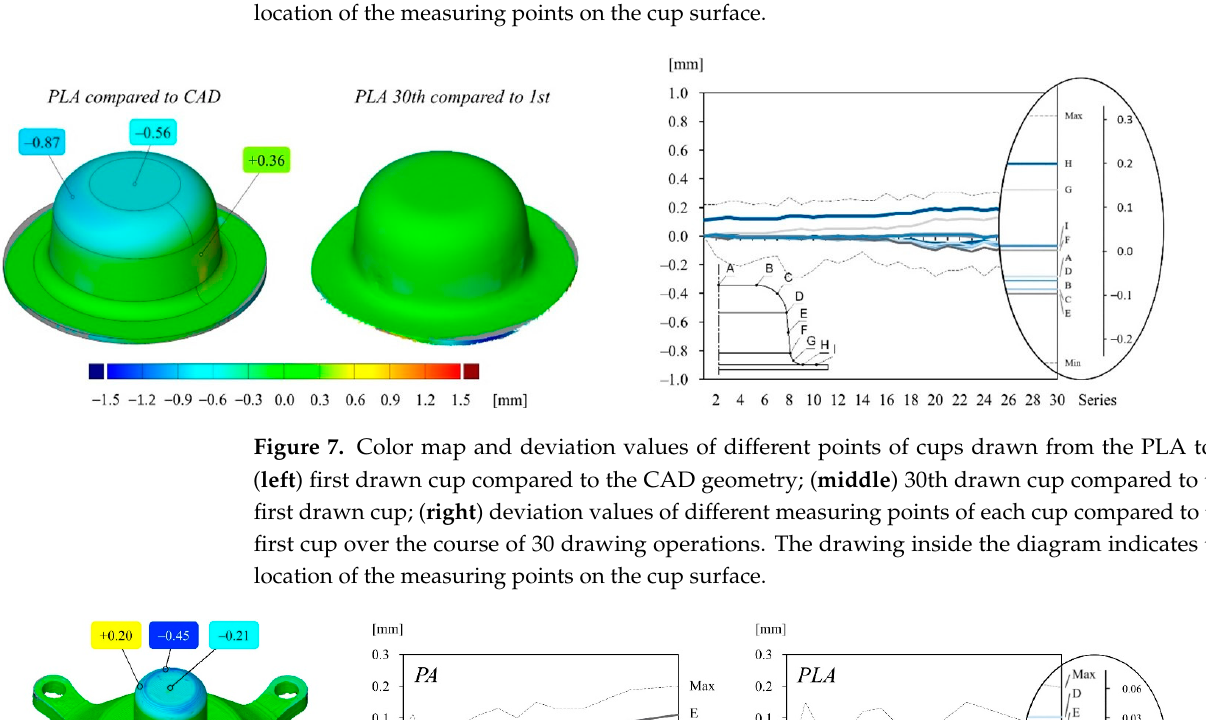
Figure 6. Color map and deviation values of different points of cups drawn from the PA tool: ( left ) first drawn cup compared to the CAD geometry; ( middle ) 30th drawn cup compared to the first drawn cup; ( right ) deviation values of different measuring points of each cup compared to the first cup over the course of 30 drawing operations. The drawing inside the diagram indicates the location of the measuring points on the cup surface.